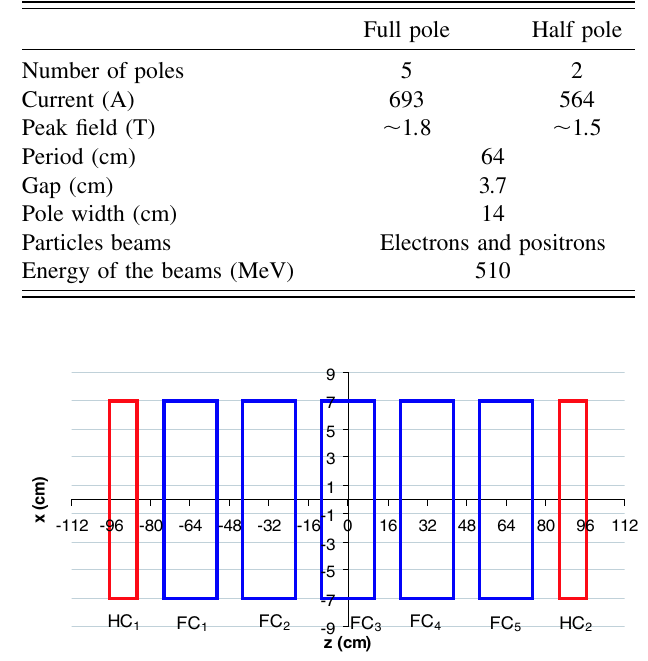
FIG. 4. (Color) Scheme of one of the wigglers of DA (cid:1) NE in the z - x plane in the present configuration.